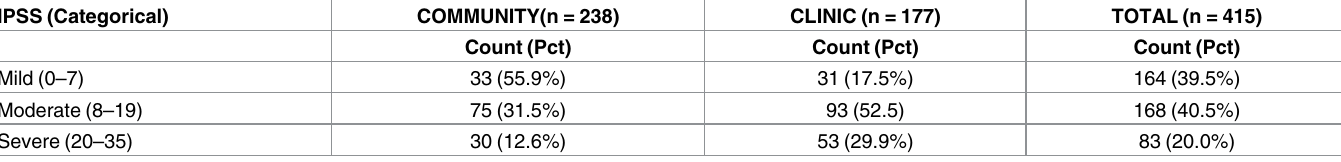
Table 2. Comparison of sites by International Prostate Symptom Score (IPSS) severity category (IPSS). IPSS (Categorical)